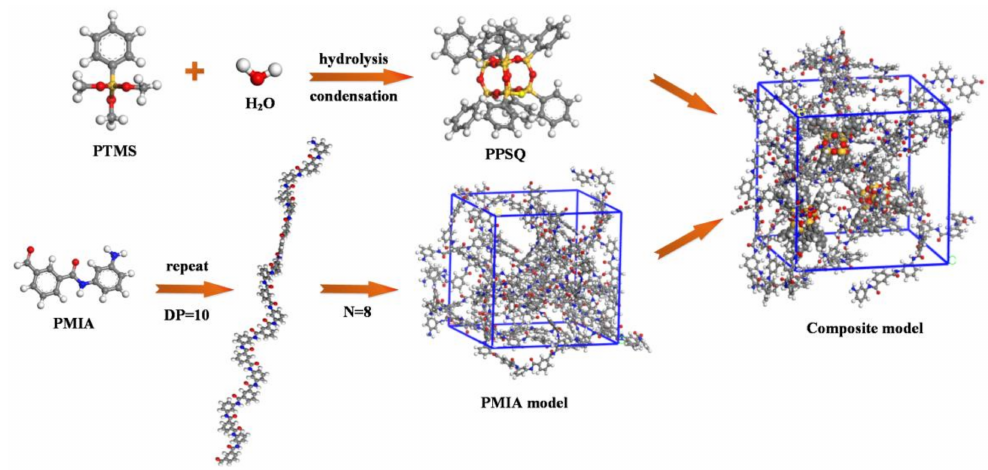
Figure 6. Schematic diagram of the constructed